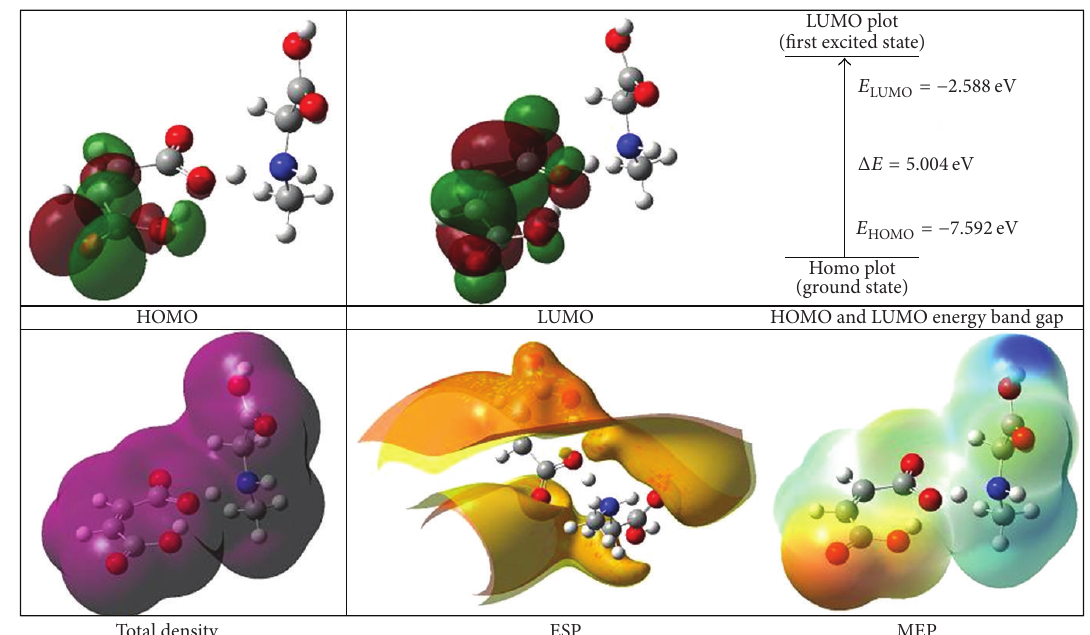
F 4: Molecular surfaces of the sarcosine-maleic acid (obtained from B3LYP method).